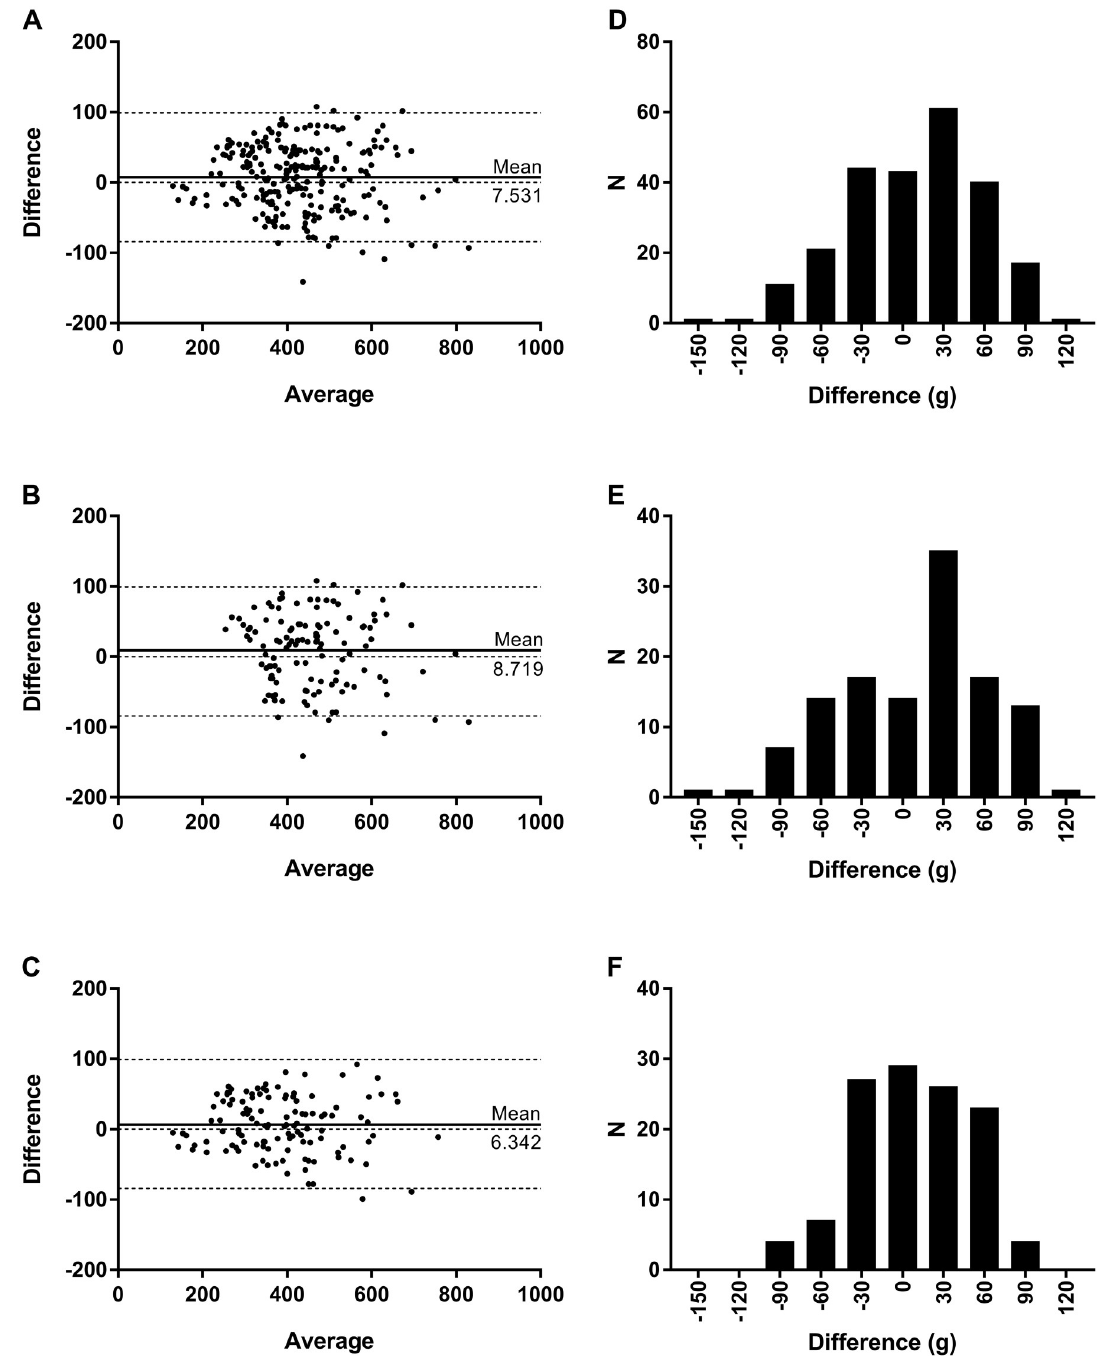
Fig 3. Device-standard agreement for Samsung Gear S2. (A-C) Bland-Altman plots of average versus difference for perspiration measurements of DBM Samsung Gear S2 (g) compared against participant weight change (g) for (A) all participants, (B) men, and (C) women. Solid line, line of equality; dotted lines, upper and lower bounds of 95%CI of the line of equality. (D-E) Frequency distribution histograms of method measurement differences (g) for (D) all participants, (E) men, and (F) women.